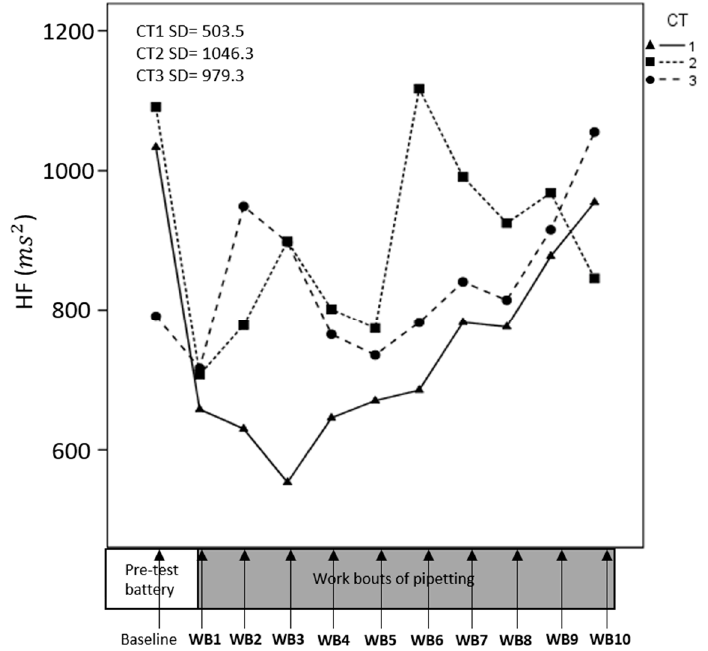
Figure 5. Development of root mean square of the successive di ff erences between R–R intervals (RMSSD) across consecutive pipetting work-bouts (WB). At each time point on the x-axis, corresponding to the pipetting work bouts, a mean value for RMSSD across participants is presented. Separate lines illustrate cognitive task (CT) di ffi culties. Standard deviations for means across all participants and all time points.